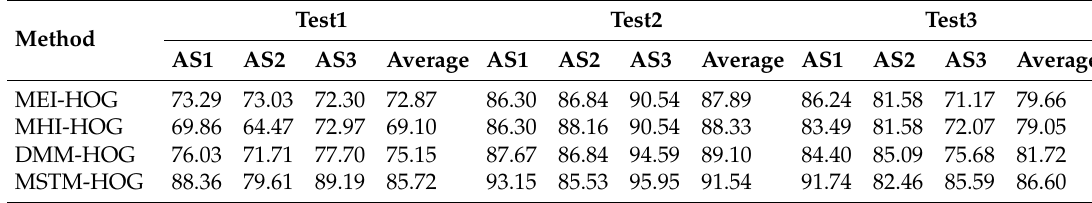
Table 2. The recognition rates (%) of different methods on D1.